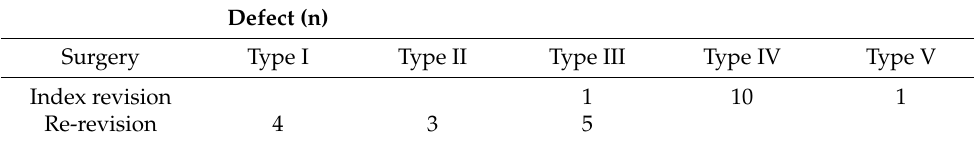
Table 2. Gross classification of acetabular bone loss at index and re-revision surgery.